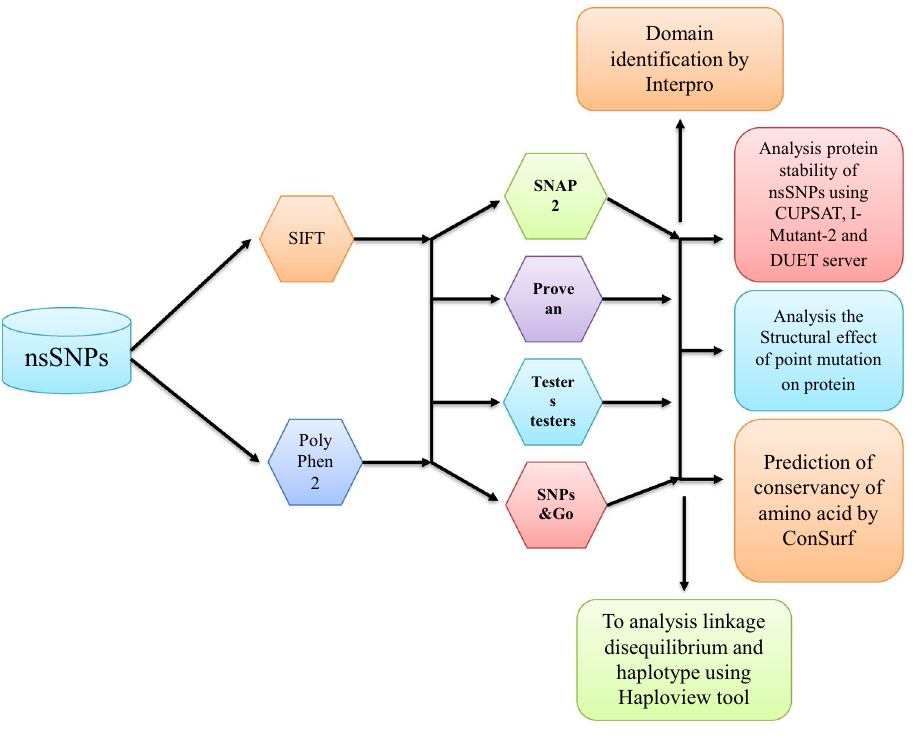
Figure 1. Schematic diagram summarizing the